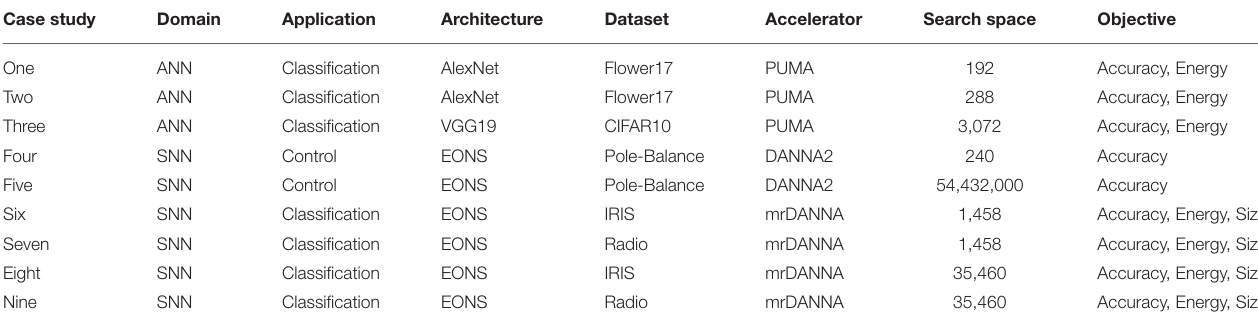
TABLE 2 | Case studies for hierarchical-PABO.